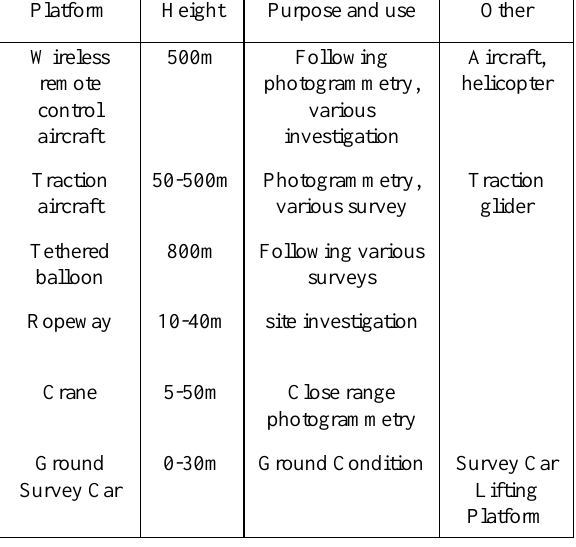
Table 1. Applicable remote sensing platform